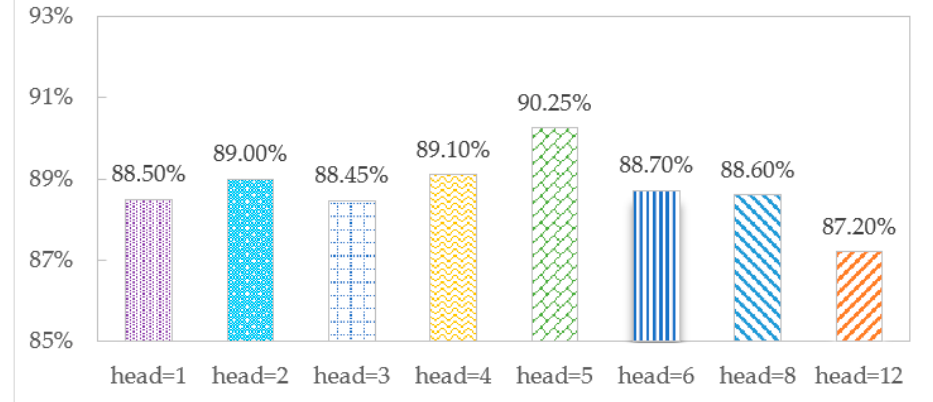
Figure 7. Accuracy comparison for different numbers of heads on the SHL dataset.